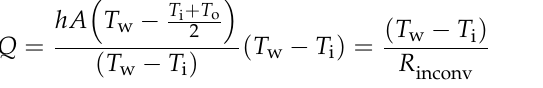
Figure 15. Comparison of the simulated and calculated heat transfer coefficients. ( a ) Different wind velocities; ( b ) different channel lengths.